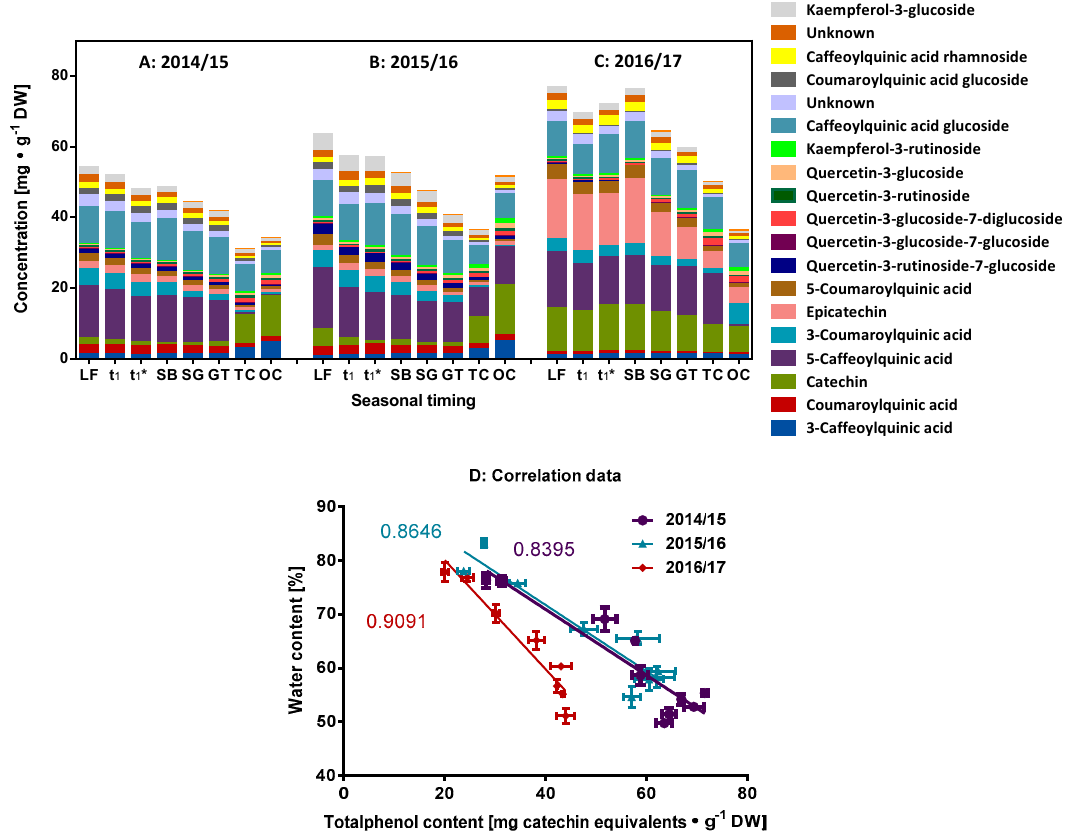
Figure 2. Composition of the main phenolic compounds at different developmental milestones, as determined by HPLC. ( A ) Season 2014/15; ( B ) Season 2015/16 and ( C ) Season 2016/17. ( D ) Correlation of the content of total phenolic compounds with the water content of the buds for the phenophase t 1 *–OC. Abbreviations: LF, leaf fall; t 1 = endodormancy release, t 1 * = beginning of ontogenetic development, SB = swollen bud, SG = side green, GT = green tip, TC = tight cluster, OC = open cluster; DW, dry weight.